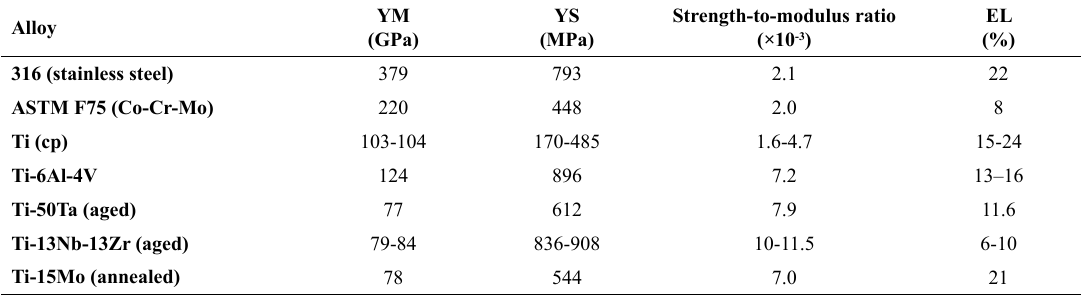
Table 1. Mechanical properties of typical biomaterials 11